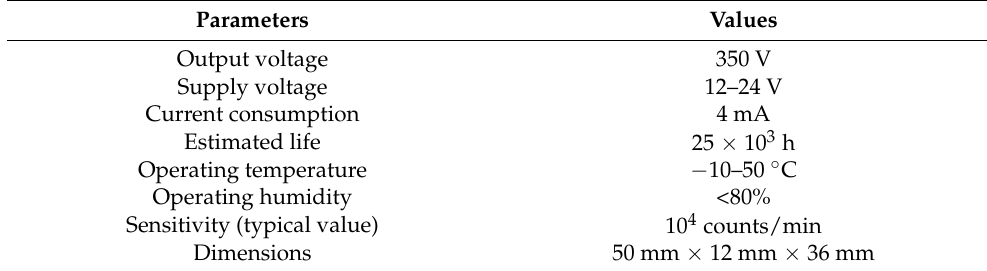
Table 2. Hamamatsu C10807 driver circuit used to supply the UV